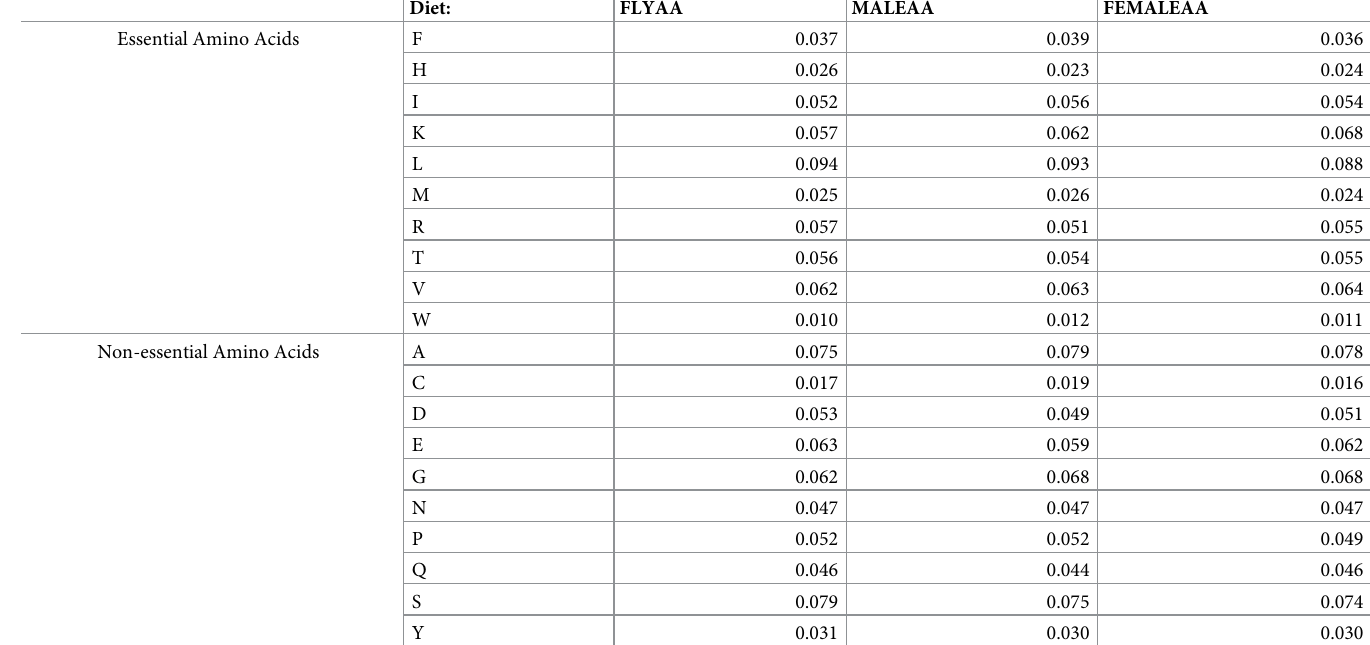
Table 5. Molar Ratio Dietary Amino